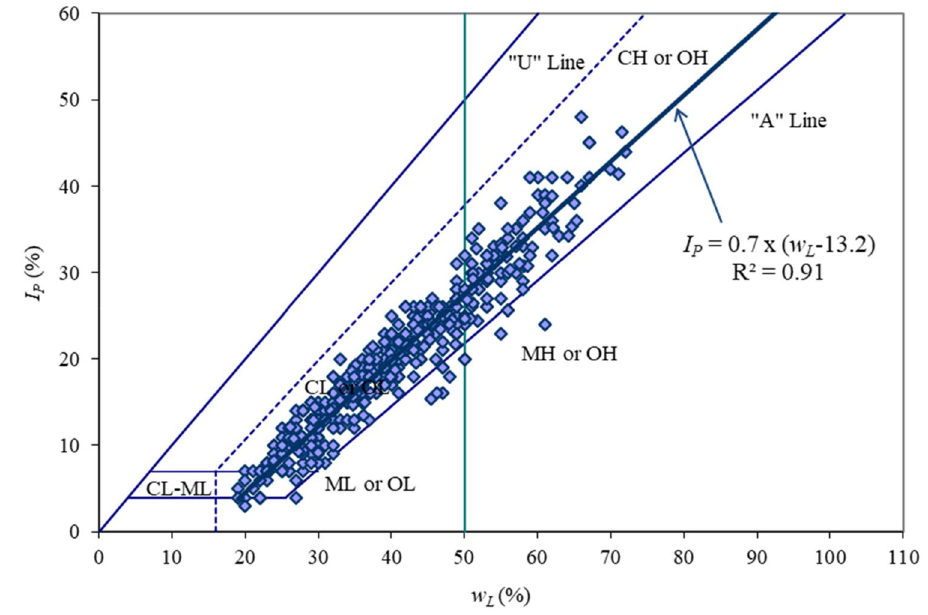
Fig. 3 Casagrande plasticity chart for Prazeres Clay